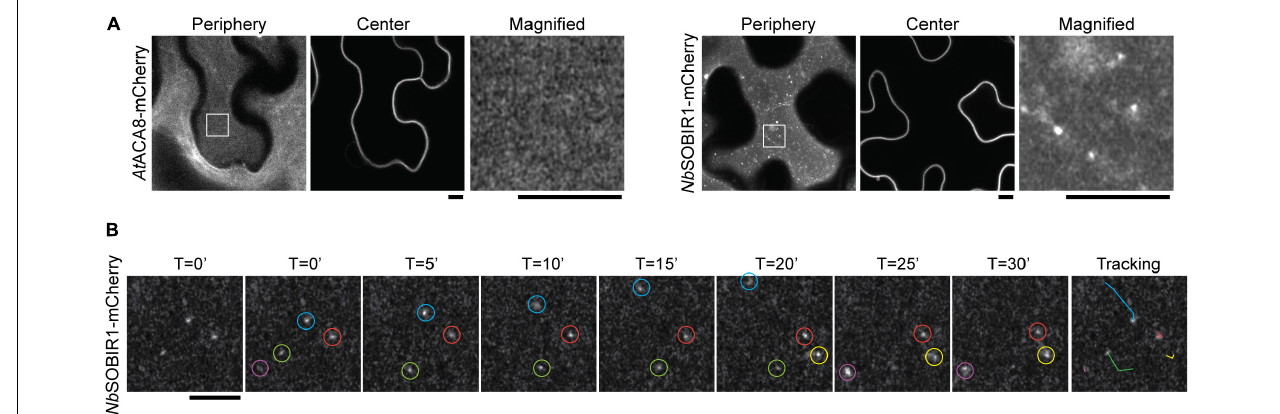
FIGURE 4 | Nb SOBIR1-mCherry forms microdomains in the plant plasma membrane. (A) Nicotiana benthamiana leaves expressing At ACA8-mCherry or Nb SOBIR1-mCherry were imaged at the periphery or center sections using Zeiss LSM880 confocal microscope with Airyscan. The box area in the image of the periphery section was enlarged and displayed to show the microdomains of Nb SOBIR1 that were not detectable on At ACA8-mCherry images. Scale bar, 5 µ m. (B) N. benthamiana leaves expressing Nb SOBIR1-mCherry was subjected to time-lapse microscopy by Zeiss LSM880 confocal microscope with the Airyscan. The total image acquisition length was 16 min with a time interval of 5 s ( Supplementary Movie 1 ). Representative area was selected for particle tracking analysis using the ImageJ, and the image of each time point is shown. Five microdomains, each circled by different colors were identified in the displayed image and their tracks are shown in the right-most